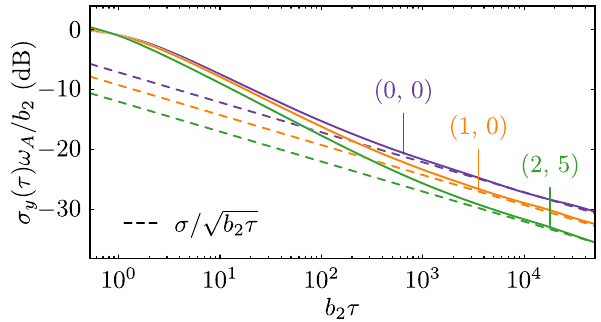
FIG. 9. Allan deviation representing a single run of a flicker- frequency-noise-limited clock servo loop based on variationally optimized N ¼ 64 particle interferometers at different circuit com- ; n plexities ð n and a Ramsey interrogation time b 2 T ≈ 0 . 5 en de Þ (solid lines). For comparison the long time scaling predicted by Eq. (25) is shown by the dashed